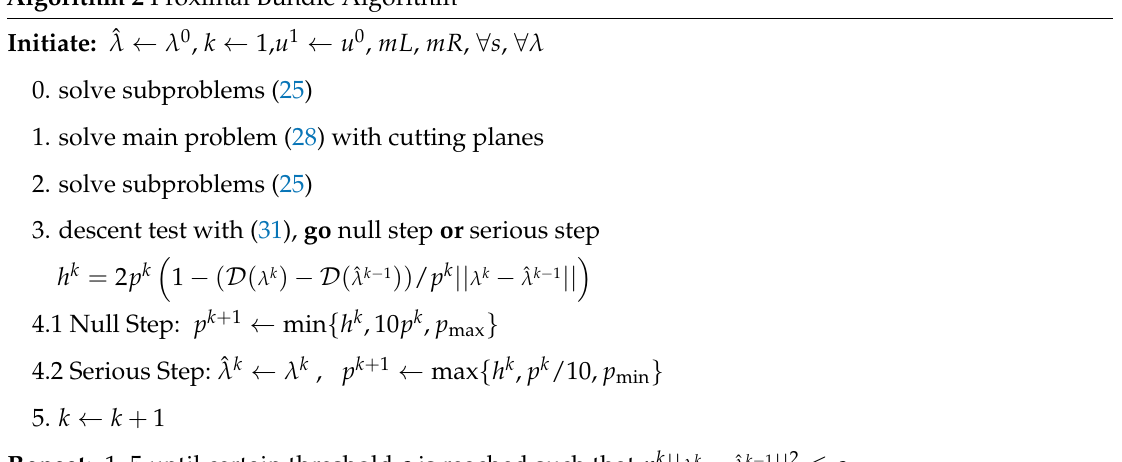
Algorithm 2 Proximal Bundle